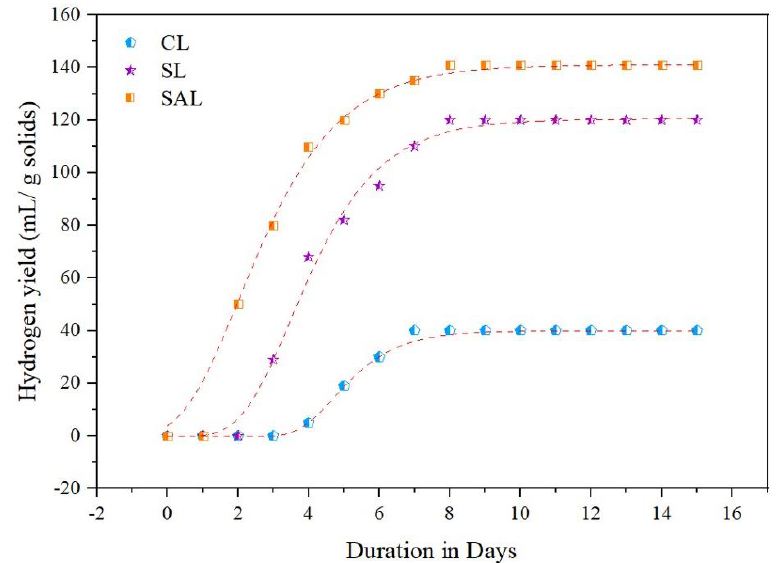
Figure 5. Biohydrogen generation in CL, SL and SAL.